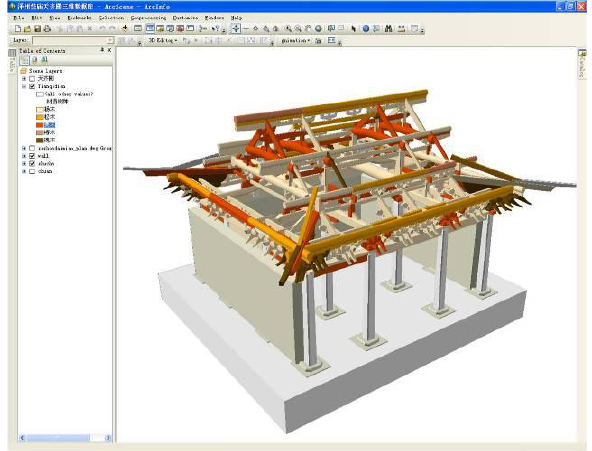
Figure 16 Timber species of wood structure of Tianqi Shrine